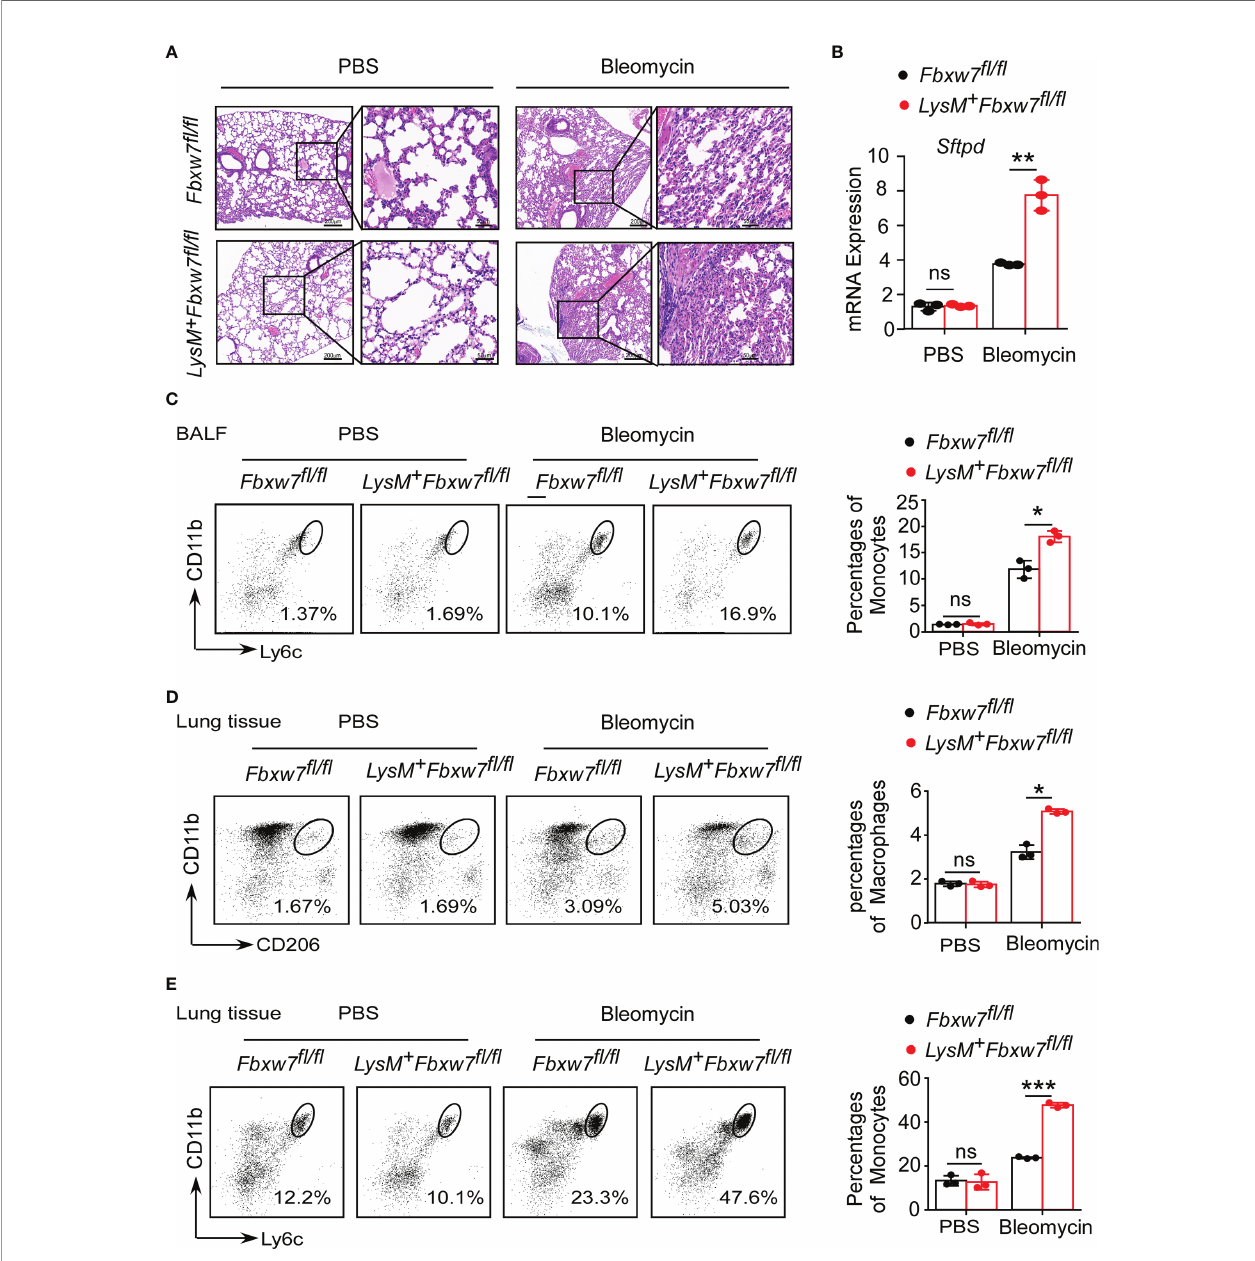
FIGURE 3 | Fbxw7 de fi ciency increases recruitment of monocytes and macrophages after bleomycin-induced lung injury. Fbxw7 fl / fl and LysM + Fbxw7 fl / fl mice were administered PBS or bleomycin for 21 days to induce pulmonary fi brosis. (A) H&E staining of lung sections, scale bars 200 m m (whole pulmonary section), and 50 m m (detail). (B) qRT-PCR analysis of relative expression of Sftpd in lung tissue. Flow cytometry and statistical analysis of the percentage of CD11b + Ly6C + monocytes in bronchoalveolar lavage fl uid (BALF) (C) , CD11b + CD206 + IMs (D) and CD11b + Ly6C + monocytes (E) in lung tissues, data are expressed as mean ± SD of biological duplicates (n=3) and are the representative of three independent experiments. P values were obtained using two-tailed Student ’ s t test. * P < 0.05, ** P < 0.01, *** P < 0.001, ns, not signi fi